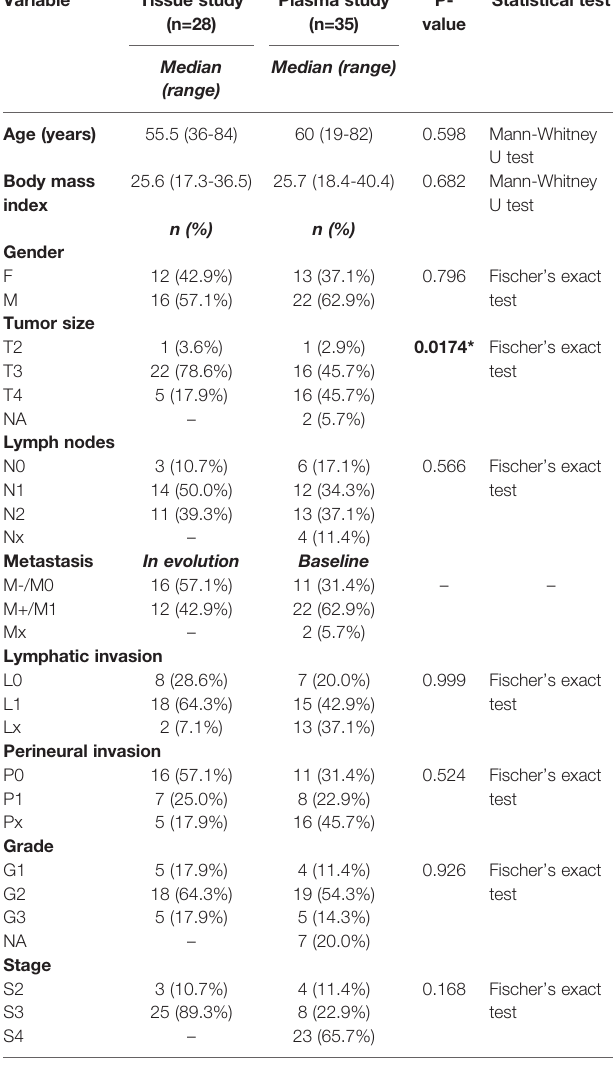
TABLE 2 | Clinical and pathological data of the patients enrolled in tissue and plasma study. Variable Tissue study